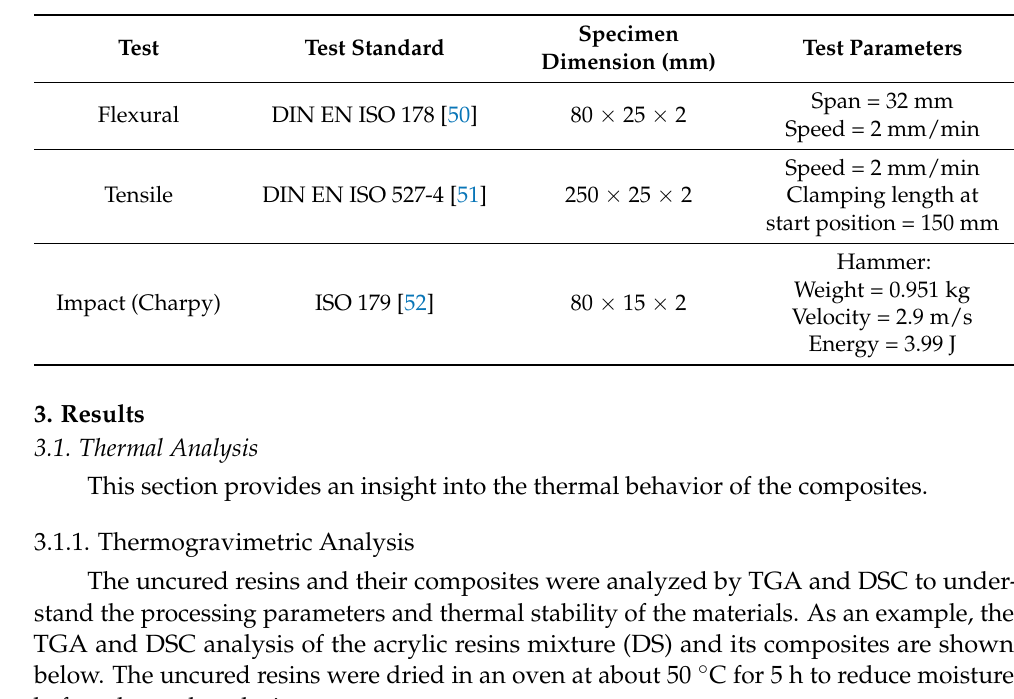
Table 4. Test procedures, standards and parameters for the mechanical characterization of